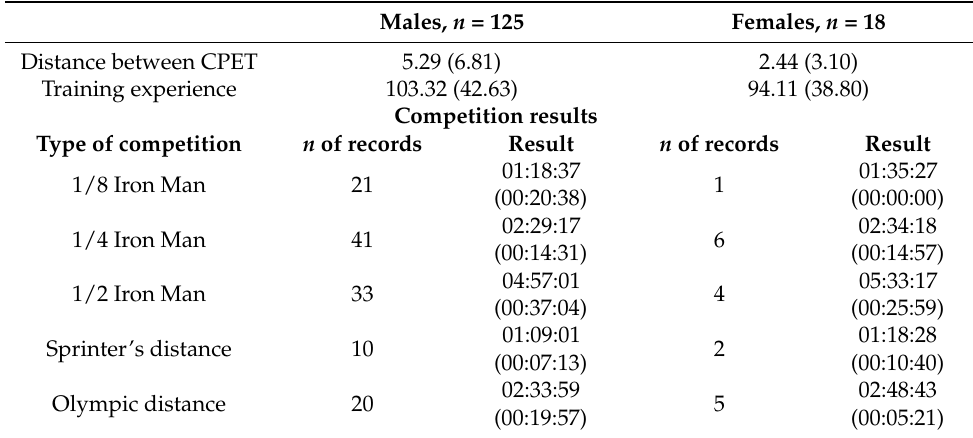
Table 2. Participant’s training experience and competition